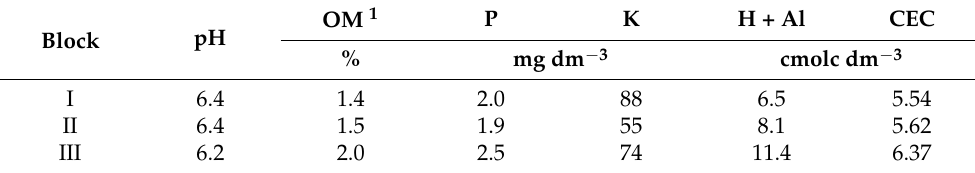
Table 2. Soil chemical characteristics (0–20 cm depth) of the experimental area before starting the